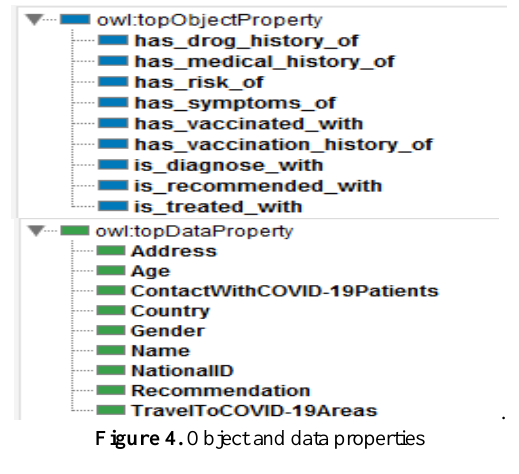
Figure 4. Object and data properties